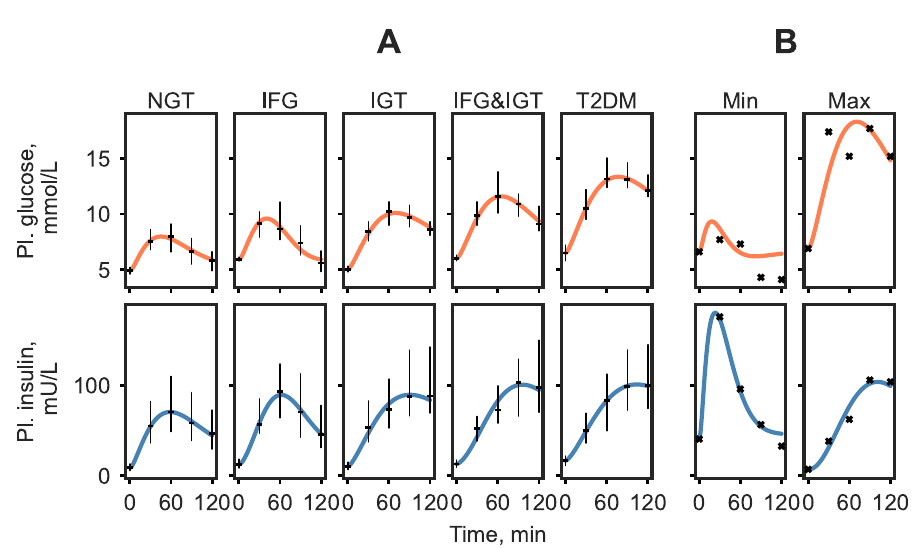
Fig 3. Plasma glucose and insulin simulation of the set of representative responses in the DIOGenes study with estimated parameters k 1, k 5, k 6, k 8. The median responses were calculated as the median plasma glucose value of the ADA diabetes classification group at each time point (A). The ‘Min’ and ‘Max’ are the smallest and largest glucose responses in the data set, determined by area under the curve (B). Median measured values are shown as black dashes with the interquartile range and measured responses are indicated by black